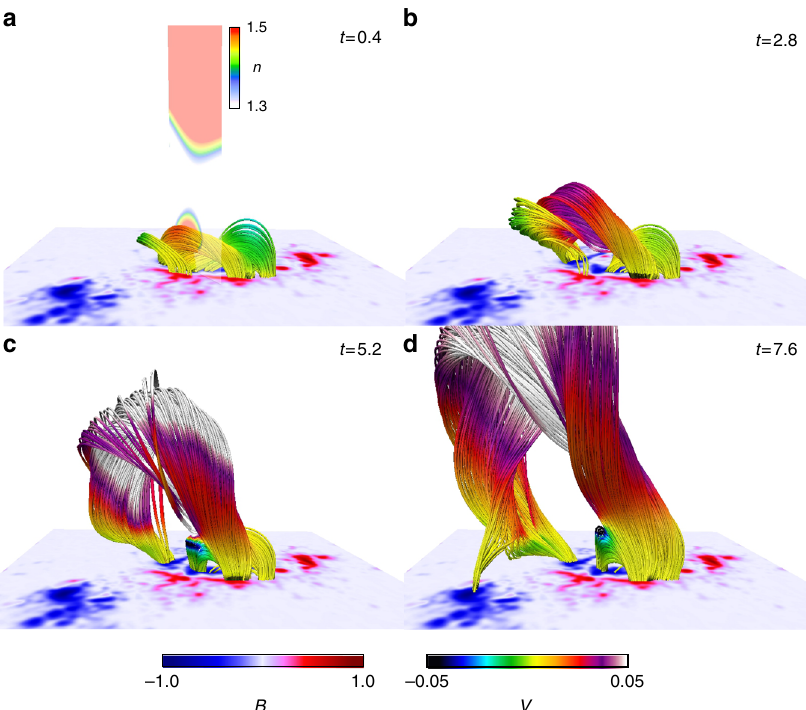
Fig. 4 Temporal evolution of the three-dimensional dynamics of the eruptive fl ux tube. a – d Temporal evolution of the dynamics of the eruptive fl ux tube, together with B z distribution at bottom. The color of the fi eld lines corresponds to the normal velocity component. The vertical cross section in a is drawn with the decay index value in range from 1.3 to 1.5